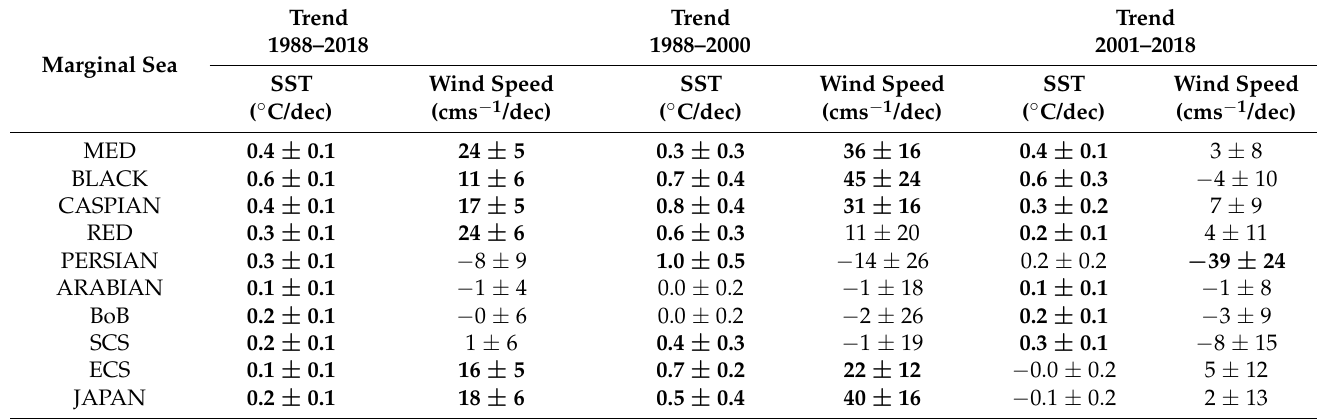
Table 4. Linear trend estimates of the annual-mean wind speed in the 10 marginal seas for three periods: 1988–2018, 1988–2000, 2001–2018. The trends that are statistically significant at the 90% confidence interval are highlighted by bold numbers. The confidence limit shown as error bars. MED: the Mediterranean Sea; BLACK: the Black Sea; and CASPIAN: the Caspian Sea; RED: the Red Sea; PERSIAN: the Persian Gulf; ARABIAN: the Arabian Sea; BoB: the Bay of Bengal; SCS: the South China Sea; ECS: the East China Sea; JAPAN: the Sea of Japan.